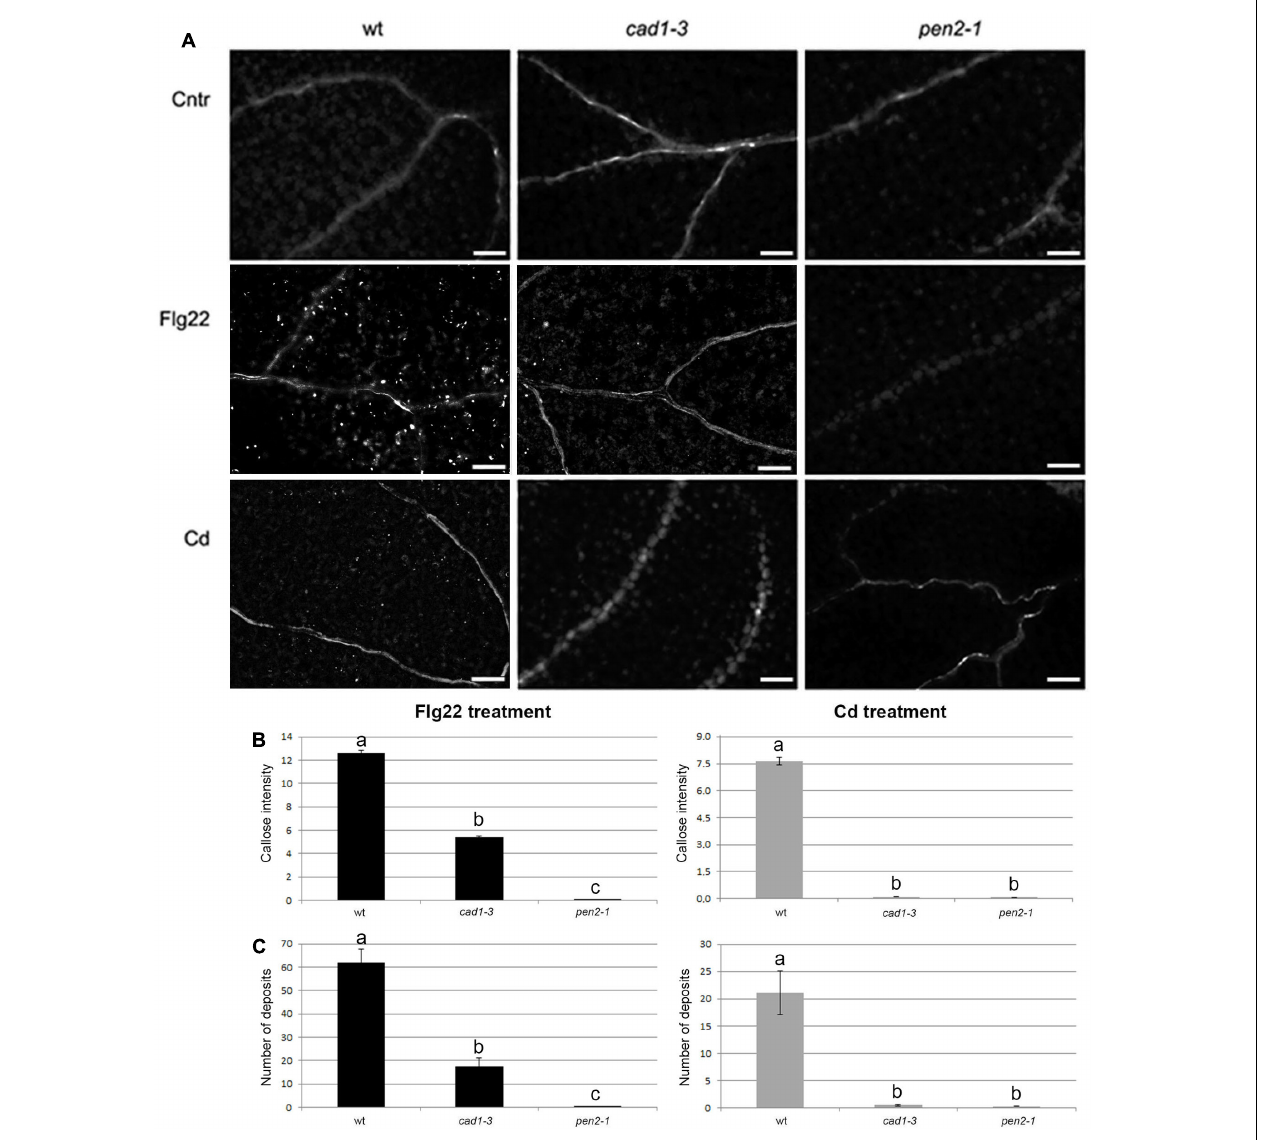
FIGURE 3 | Callose staining in cotyledons of 10-day-old wt, cad1-3 and pen2-1 plants treated for 24 h with double-distilled water (Cntr), or 1 µ M Flg22, or 25 µ M CdCl 2 . (A) Representative images of aniline blue-stained callose fluorescence (bright spots); n > 6, scale bars = 100 µ m. (B) Callose fluorescence intensity and (C) number of callose deposits, in the three lines and conditions. In (A,B) , the values represent the average of n > 6, error bars indicate SE. Statistical analysis was performed by one-way ANOVA followed by the Bonferroni’s post hoc test. Different letters indicate statistically significant differences at p ≤